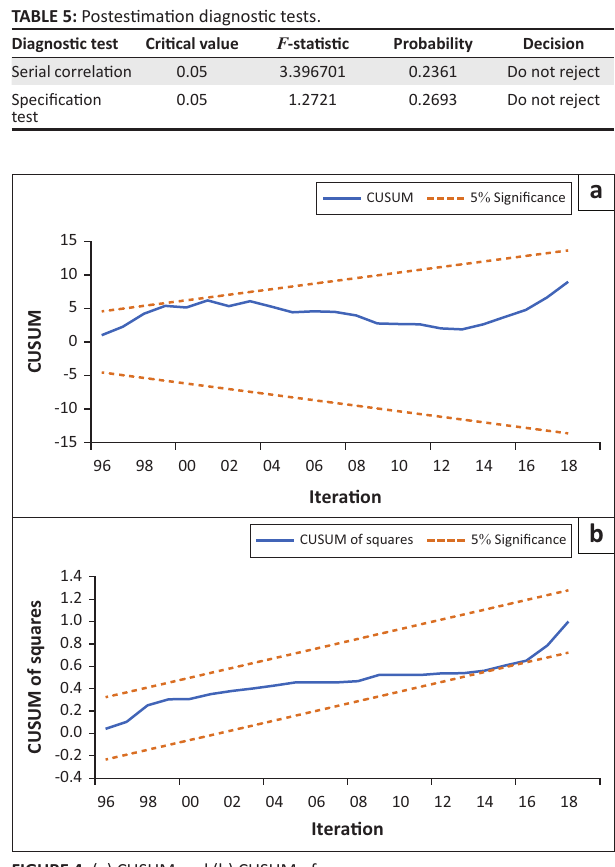
FIGURE 4: (a) CUSUM and (b) CUSUM of square. FIGURE 3: Dynamic multiplier, tax revenue on household consumption.